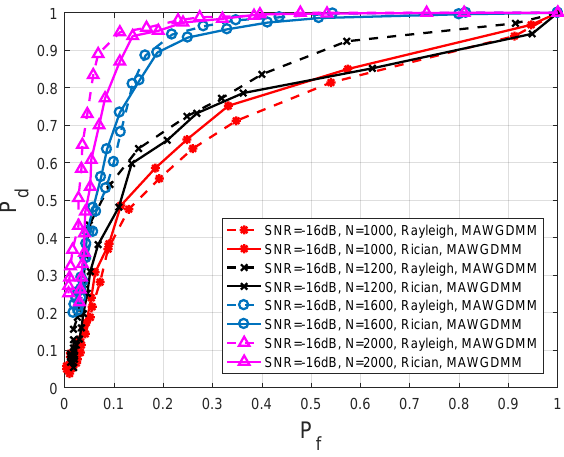
Figure 11. Comparison of ROC in different number of sampling points.